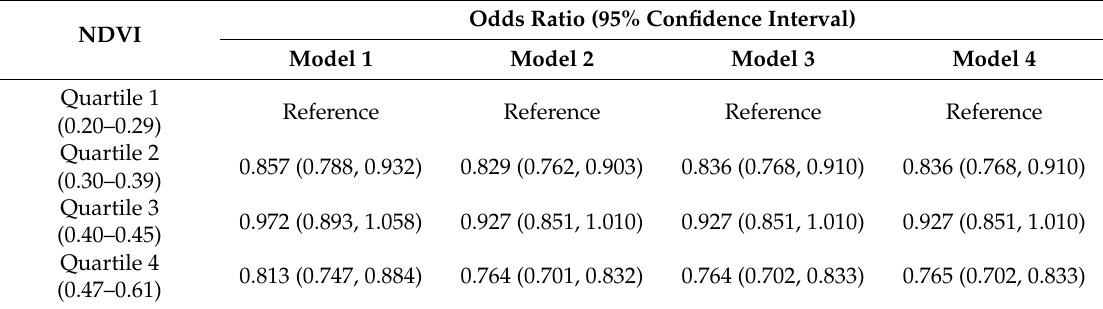
Table 3. Odds ratios for reporting depressive symptoms in the quartiles for urban greenness by